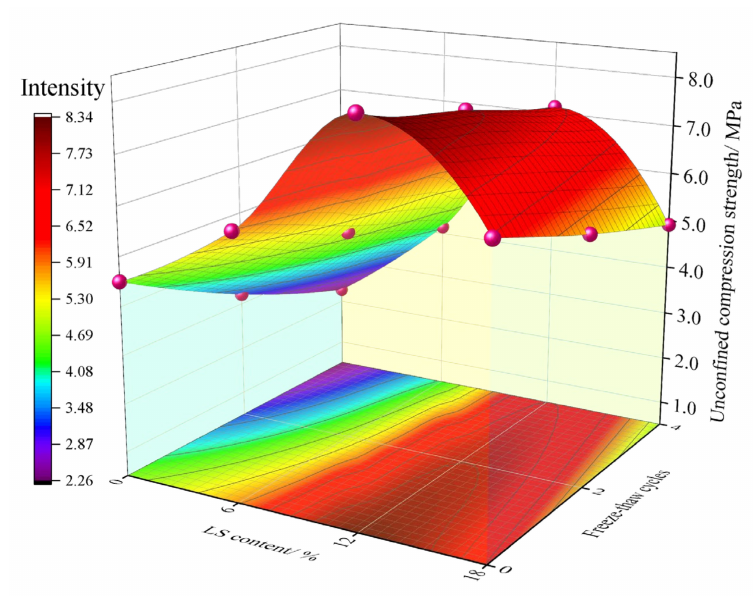
Figure 6. Effect of LS content on unconfined compression strength of cement-soil after freeze– thaw